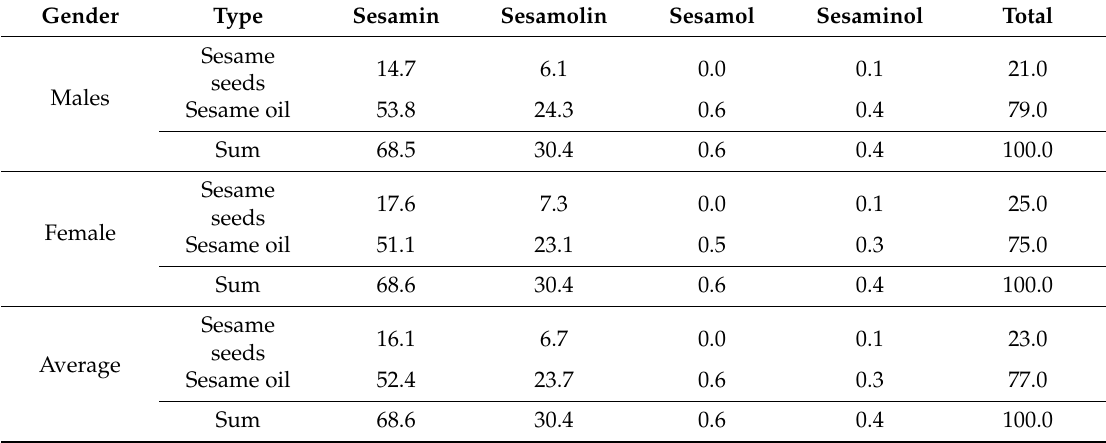
Table 8. The average contributive composition percentage (%) of sesame seed and oil for individual